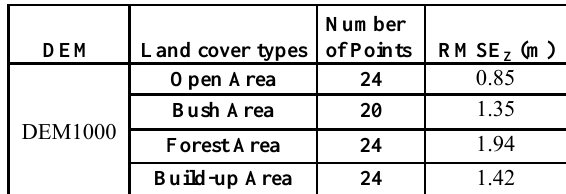
Table 2. Accuracy Analysis of DEM 1000